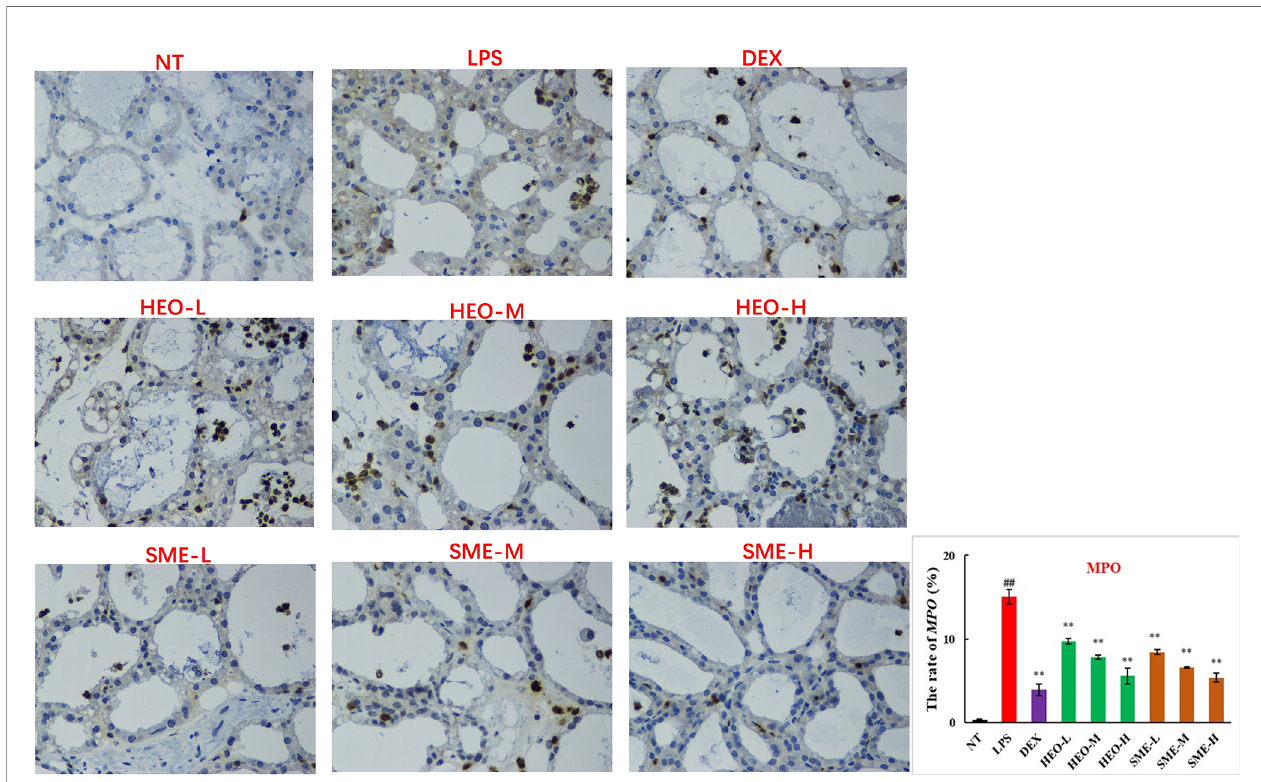
FIGURE 5 | Distribution and expression of MPO in LPS-induced murine mastitis, indicated by brown or yellow colors. Mean ± SD, n = 6. ## P < 0.01, compared to blank group; ** P < 0.01 compared to model